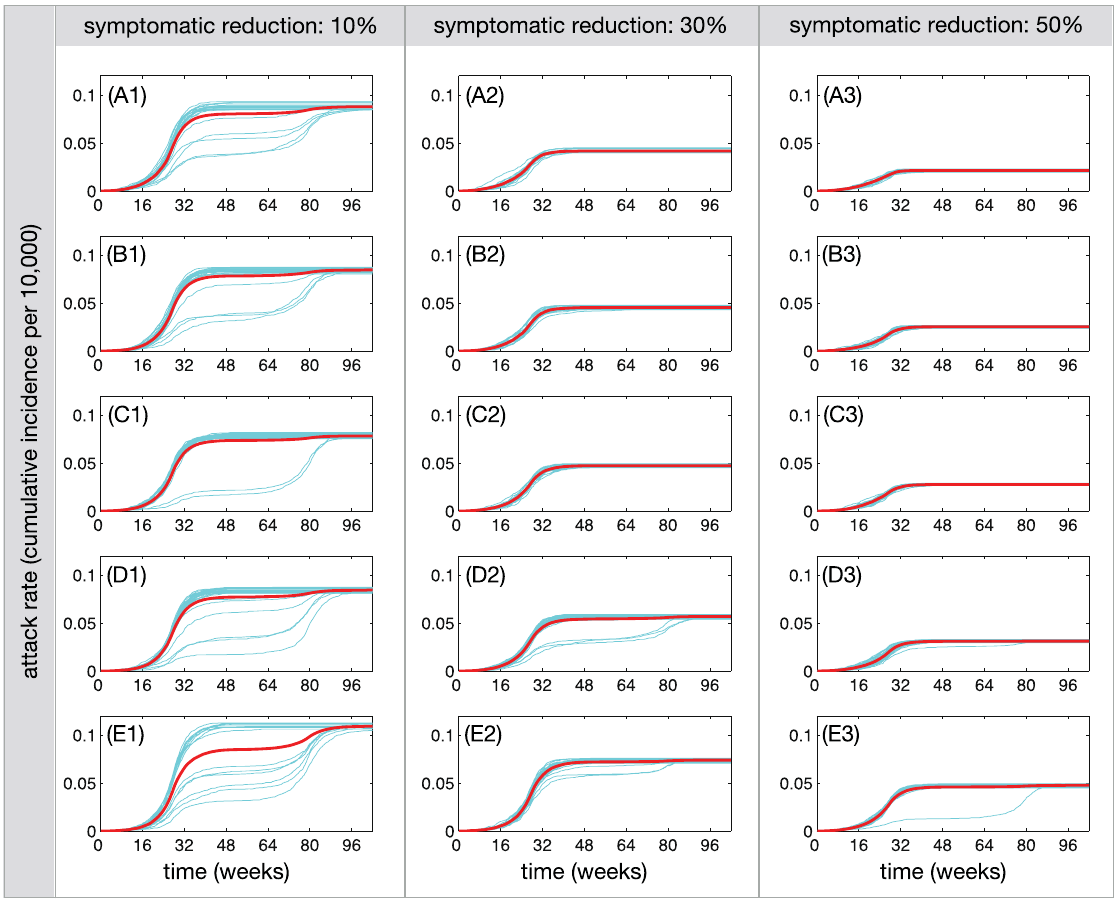
Figure 4. Attack rates (cumulative incidence per 10,000) of ZIKV infection over a 2-year period for the first and second waves, when the contribution of symptomatic ZIKV infection to disease transmission through mosquitoes was reduced by 10% (A1–E1), 30% (A2–E2), and 50% (A3–E3). The relative transmissibility of asymptomatic infection is 10% (A1,A2,A3), 30% (B1,B2,B3), 50% (C1,C2,C3), 70% (D1,D2,D3) and 90% (E1,E2,E3). The red curve represents the mean attack rate in each scenario within its 95% confidence interval.